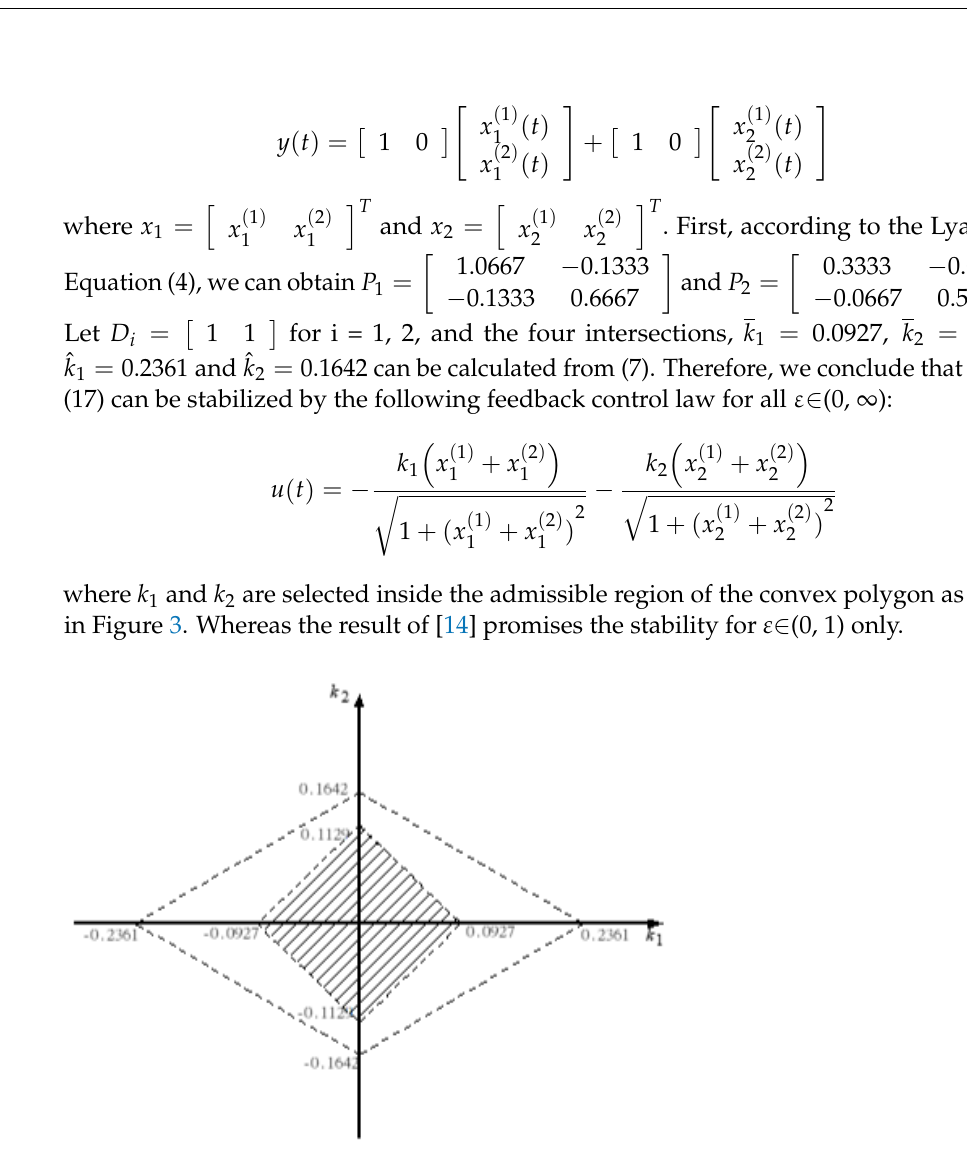
Figure 3. The admissible region k 1 and k 2 for the controller of example 1.